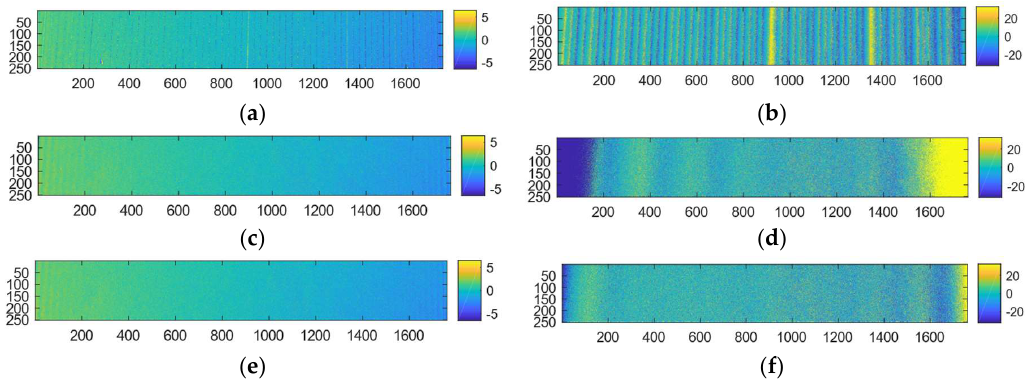
Figure 11. MFPS versus GCPS. We show the distance measurements on an area of 250 × 1800 of the top flat part of the images in Figure 7. The colorbars denote mm. Top to bottom rows contains results from GCPS, MFPS and the scatter corrected MFPS, respectively. The left and right column contains results from turbidities λ 1 = 2.0 m and λ 3 = 0.8 m, respectively.